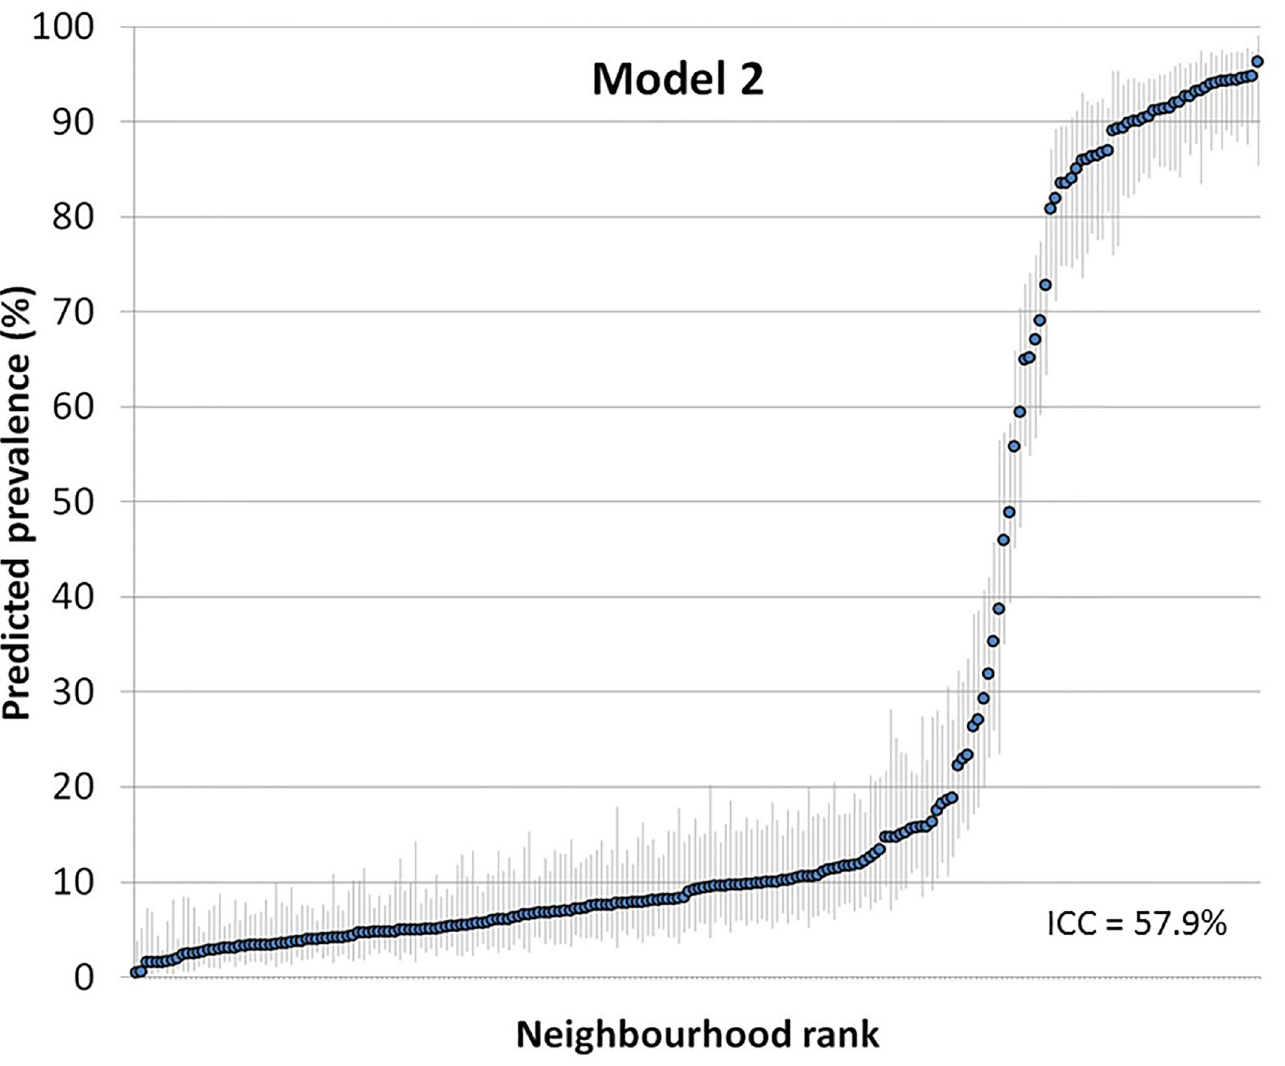
Fig 5. Predicted prevalence of using a private physician in each neighborhood with 95% confidence intervals versus ranking. Predictions are for the reference individual in model 2, i.e., female, age 35 – 39, low